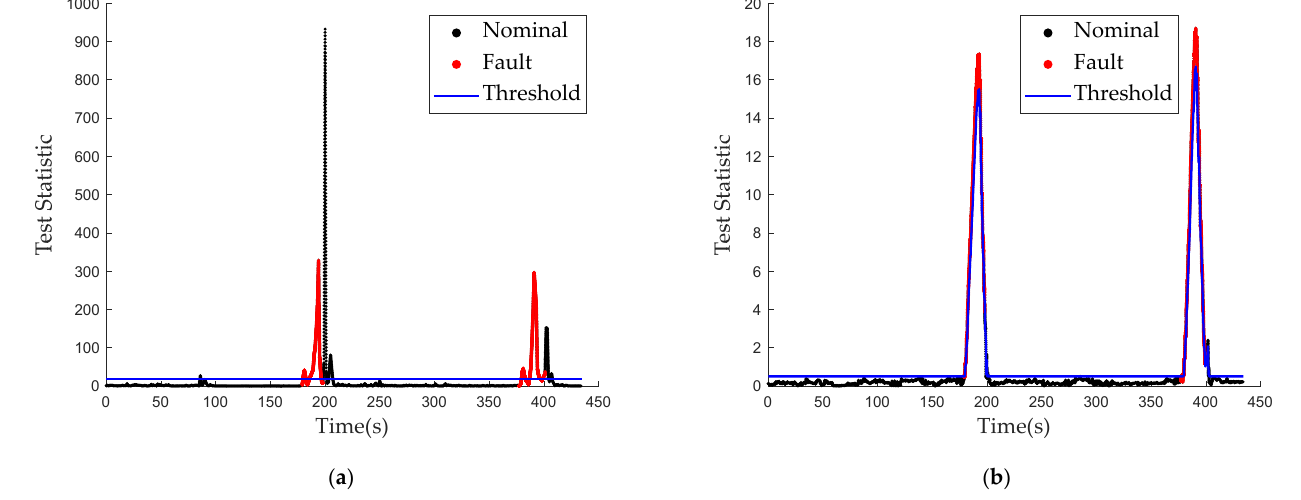
Figure 23. Fault detection results of the residual chi-square test and the proposed algorithm. ( a ) The fault detection results of the residual chi-square test. ( b ) The LiDAR aided real-time fault detection results.